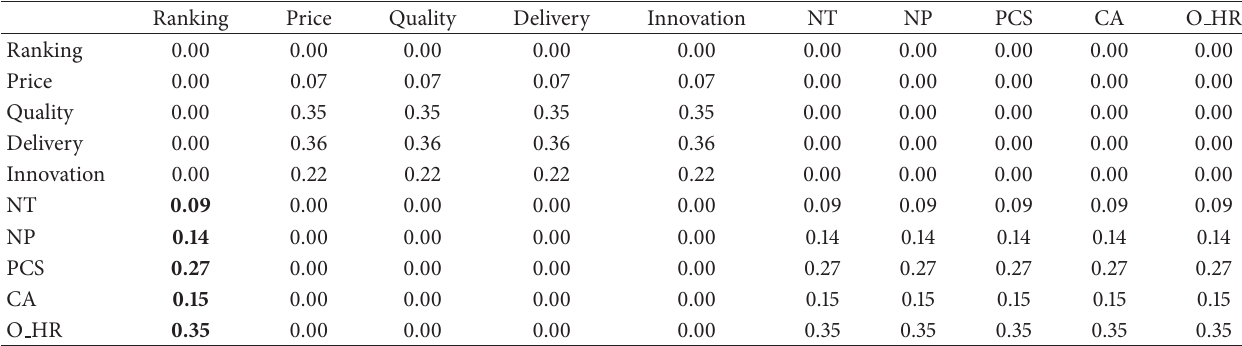
Table 11: Matrix limit corresponding to the decisions of decision agent 2.